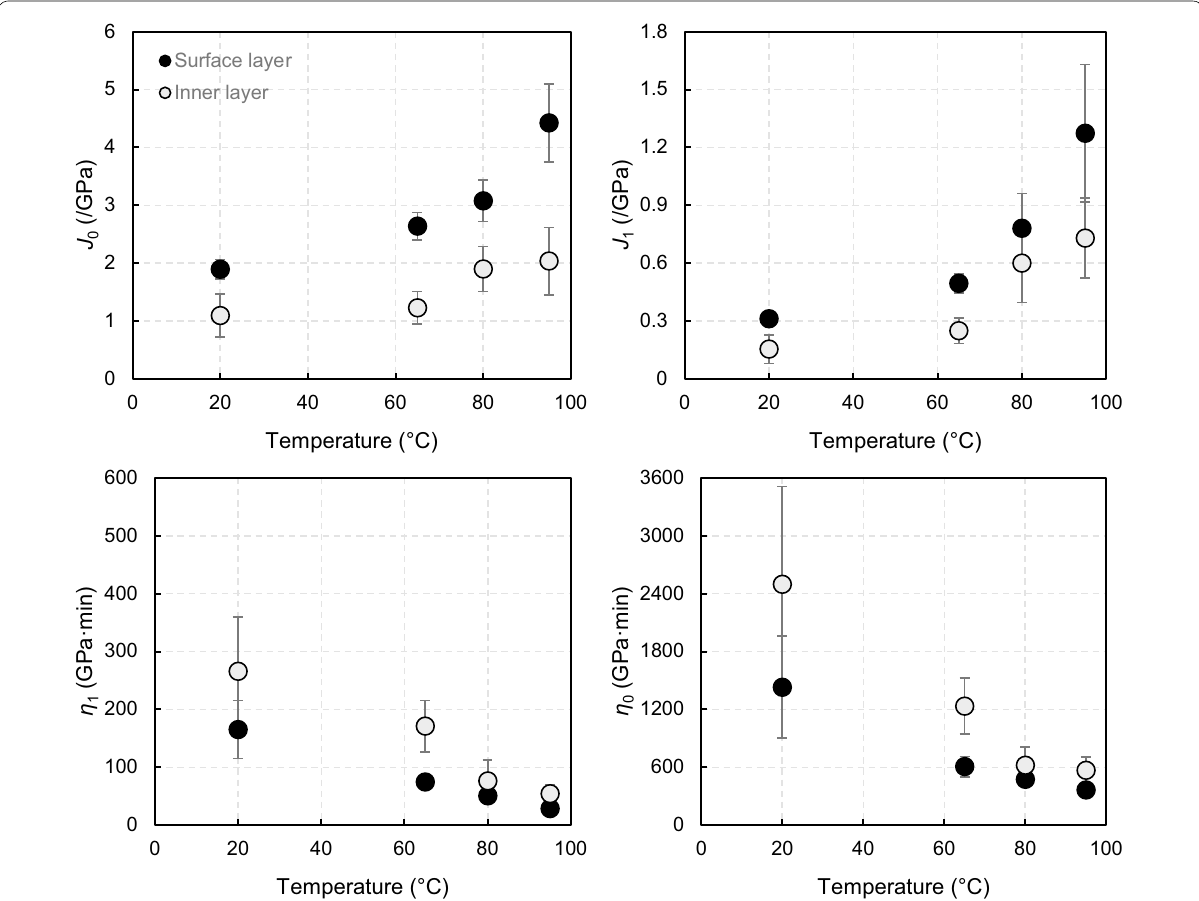
Fig. 6 Creep parameters of surface- and inner-layers of sugi boxed-heart timber at each temperature. The error bar indicates standard